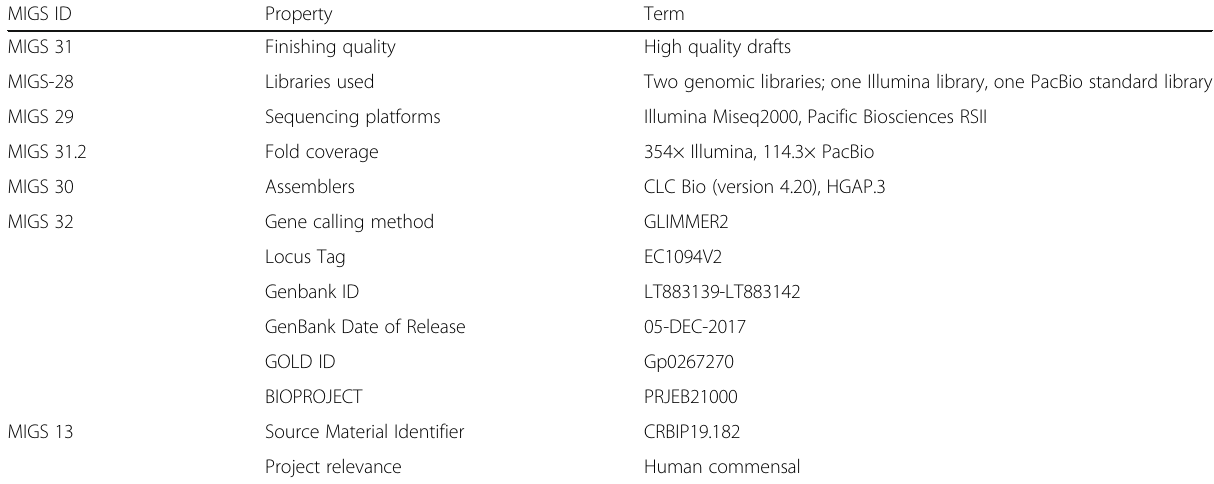
Table 2 Project